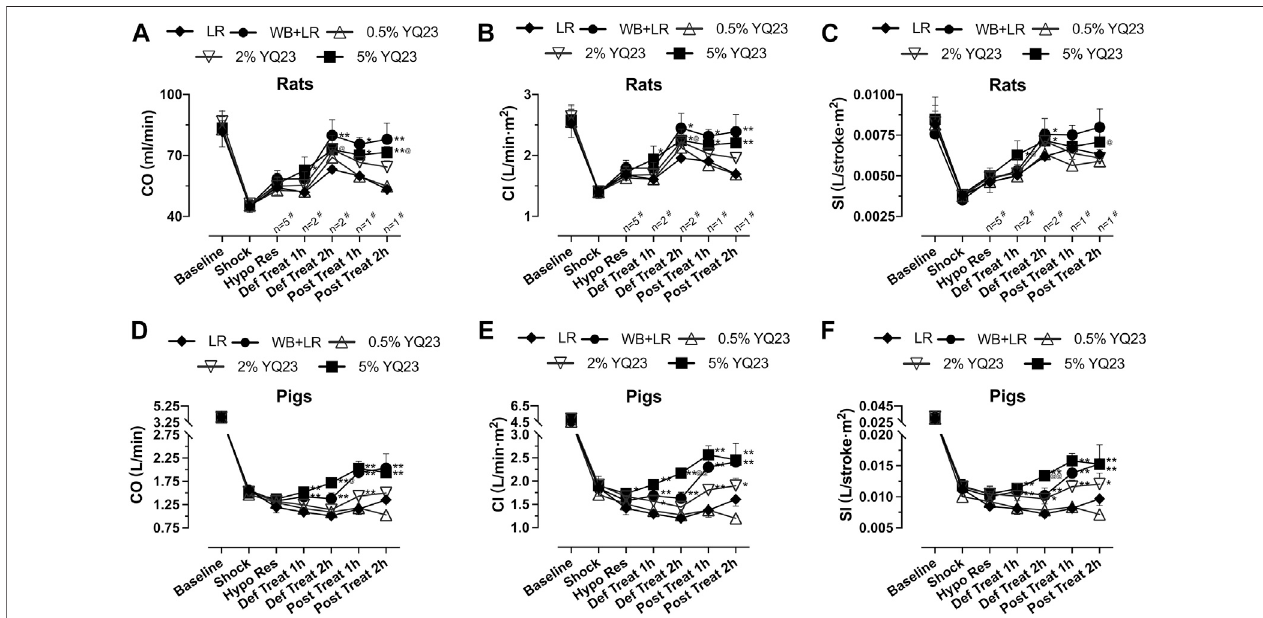
FIGURE5|YQ23 improved cardiacfunctionfollowinguncontrolledhemorrhagicshockinratsandpigs.(A) ,COinrats; (B) ,CIinrats; (C) ,SIinrats; (D) , CO in pigs; (E) , CI in pigs; (F) , SI in pigs ( n (cid:1) 10/group in rats experiment unless otherwise annotated, n (cid:1) 6/group in pig experiment). CO, cardiac output CI, cardiac index;SI,strokeindex.LR,LactateRinger ’ ssolution;WB,wholeblood.* p < 0.05v.s.LRatthesametimepoint,** p < 0.01v.s.LRatthesametimepoint, @ p < 0.05v.s. WB + LR at the same time point, @@ p < 0.01 v. s. WB + LR at the same time point, # n of LR group at the corresponding time point (sample size was decreased because of animal death).